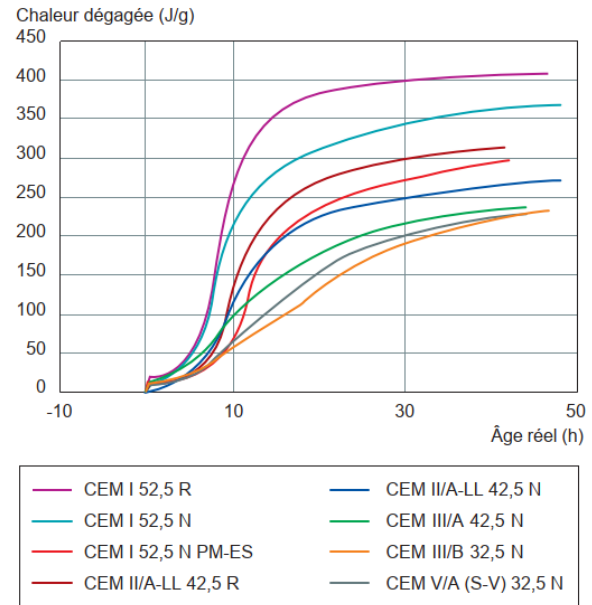
Figure 2: Hydration heat development for selected types of cement (LCPC,